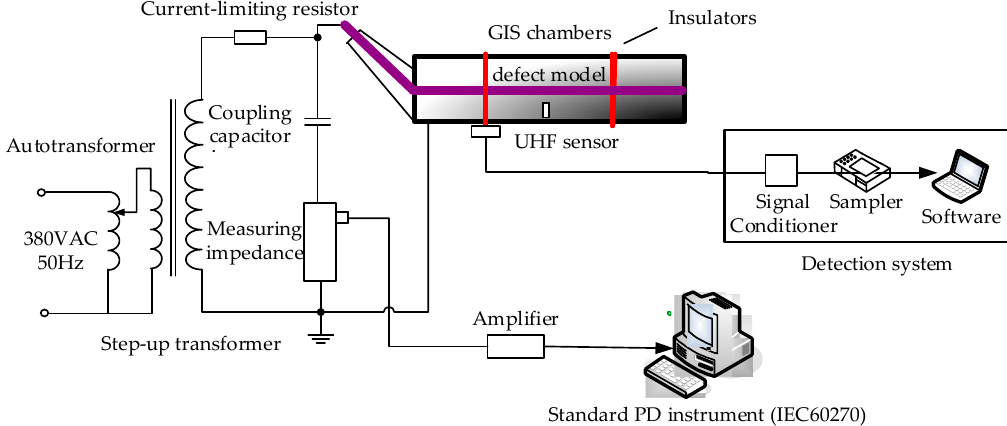
Figure 1. Test circuit of experiment platform for gas-insulated switchgear (GIS) partial discharge (PD).